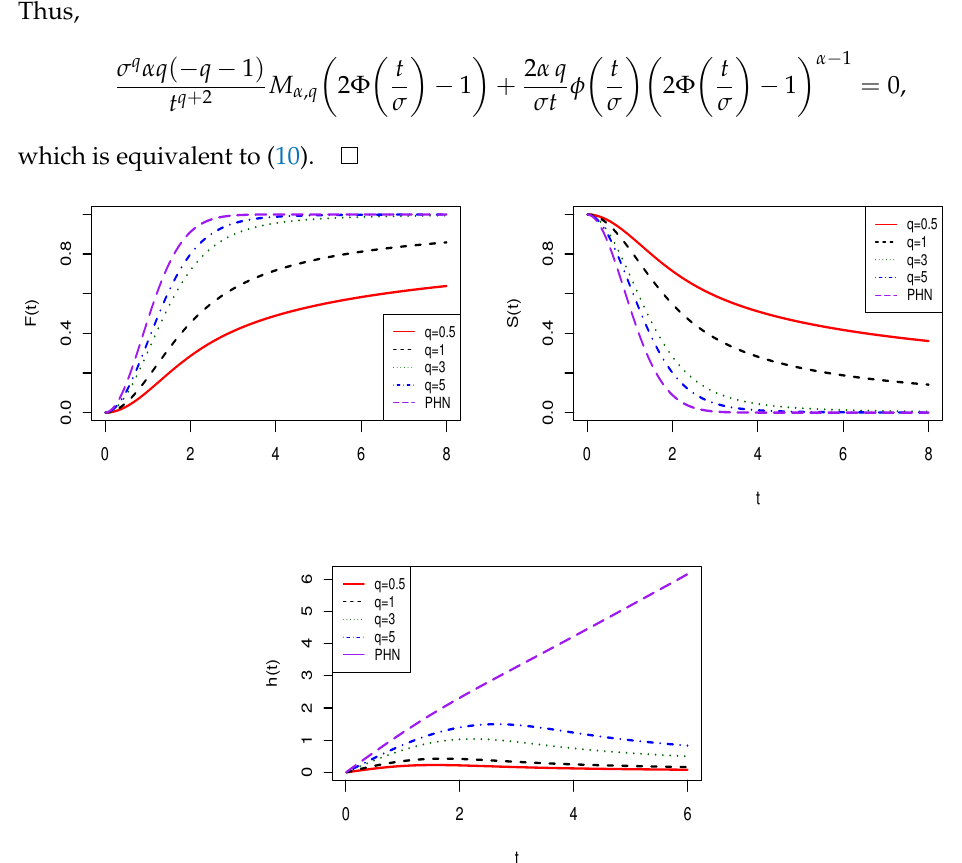
Figure 2. Plots of the cdf, survival function and hazard function for the SPHN ( 1,2, q ) .